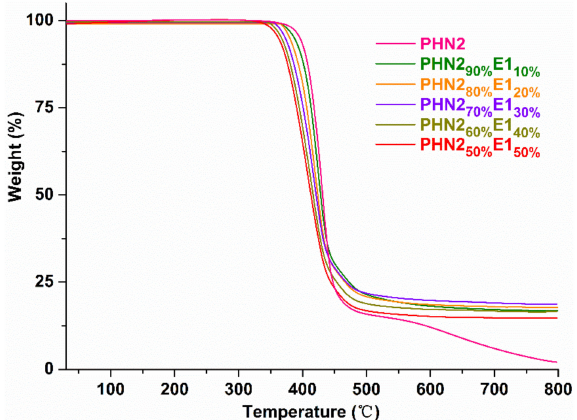
Figure 5. TGA curves of PHN2 1 − x E1 x recorded from 25–800 ◦ C at a heating rate of 10 ◦ C min − 1 under a nitrogen atmosphere.